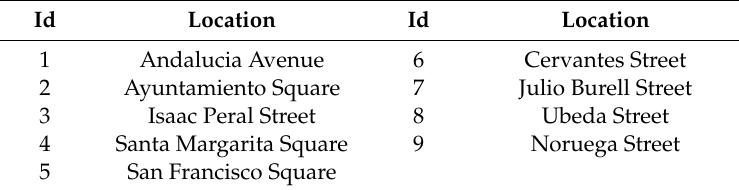
Table 2. The critical places to be